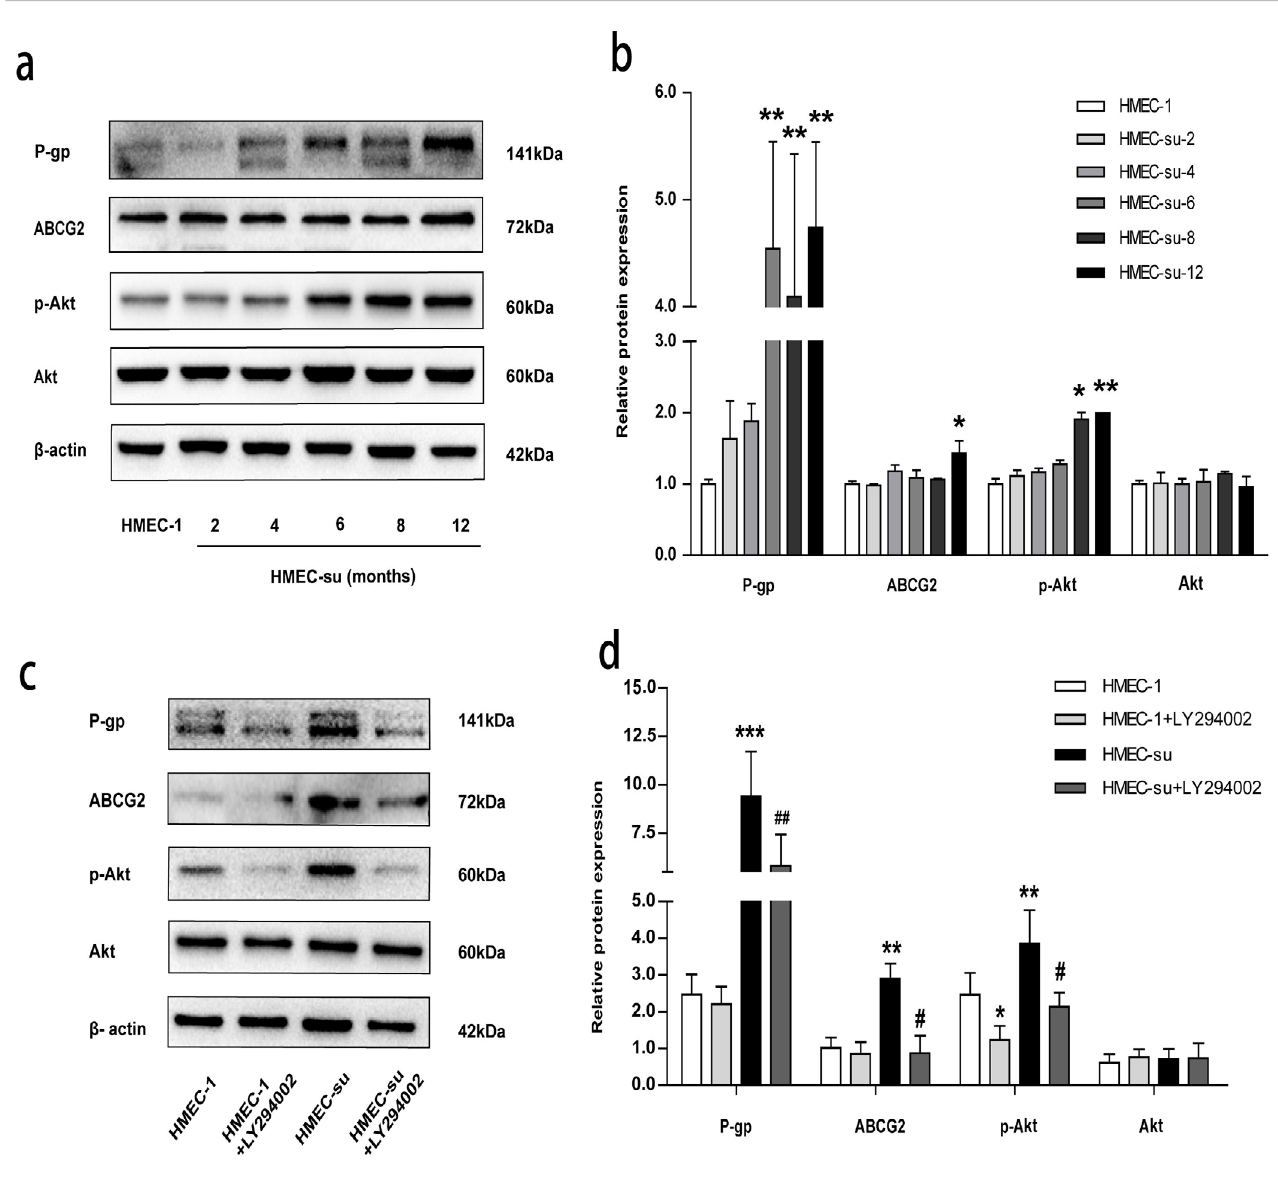
FIGURE 3 - Effect of LY294002 on MDR protein expression and Akt phosphorylation in HMEC-1 and HMEC-su cells. (a) The P-gp and ABCG2, p-Akt and Akt protein expressions in HMEC-su cells and HMEC-1 cells at different months were determined by western blotting and (b) data summary. All data were expressed as mean ± SD of three independent experiments, ** P < 0.01 and * P < 0.05 vs. HMEC-1 cells. (c) LY294002 decreases protein expression of P-gp and ABCG2 in resistance cells HMEC-su at 10 µM after treatment for 24 h, (d) relative expression levels are shown, in which the intensity of bands were divided by corresponding β-actin band. All data are shown as the mean ± SD of three separated experiments, **P < 0.01 and *P < 0.05 vs. HMEC-1 cells, ## P < 0.01 and # P < 0.05 vs. HMEC-su